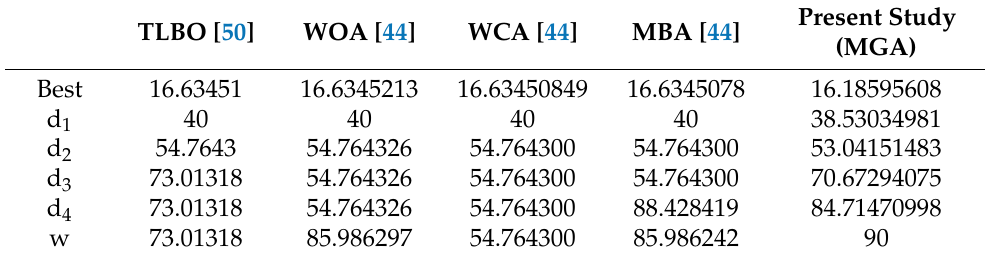
Table A15. Comparison of the best solutions for the step-cone pulley design